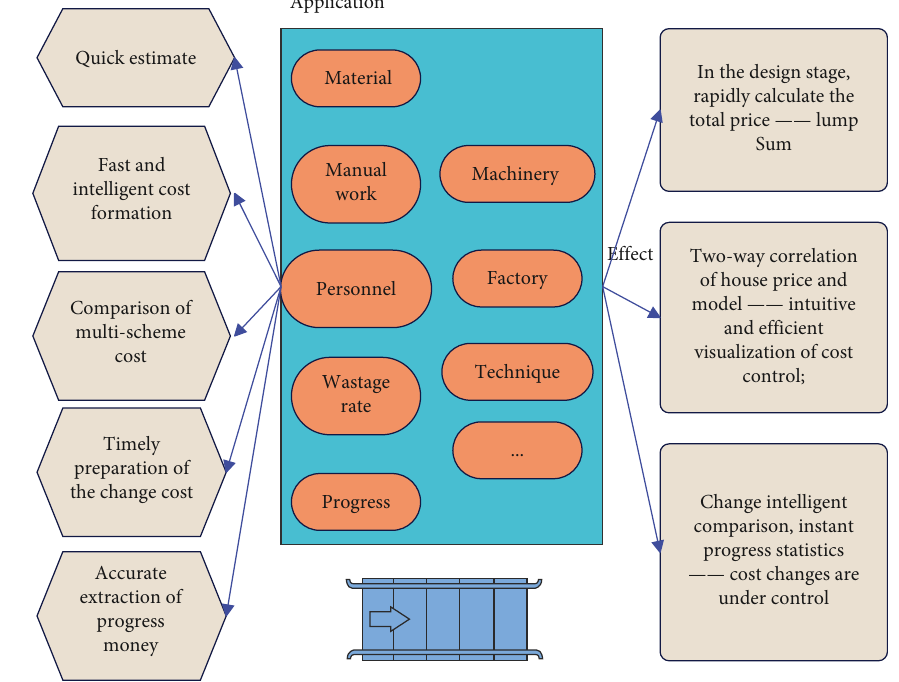
Figure 15: Example of project cost management using BIM technology.